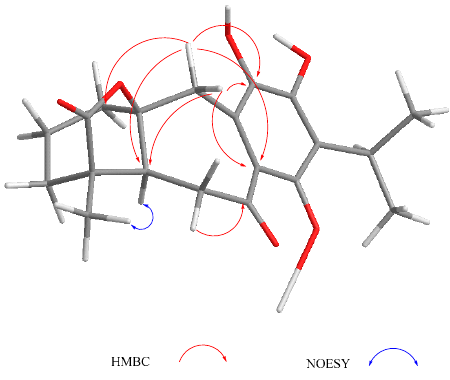
Figure 6. Selected correlations for compound 4 .